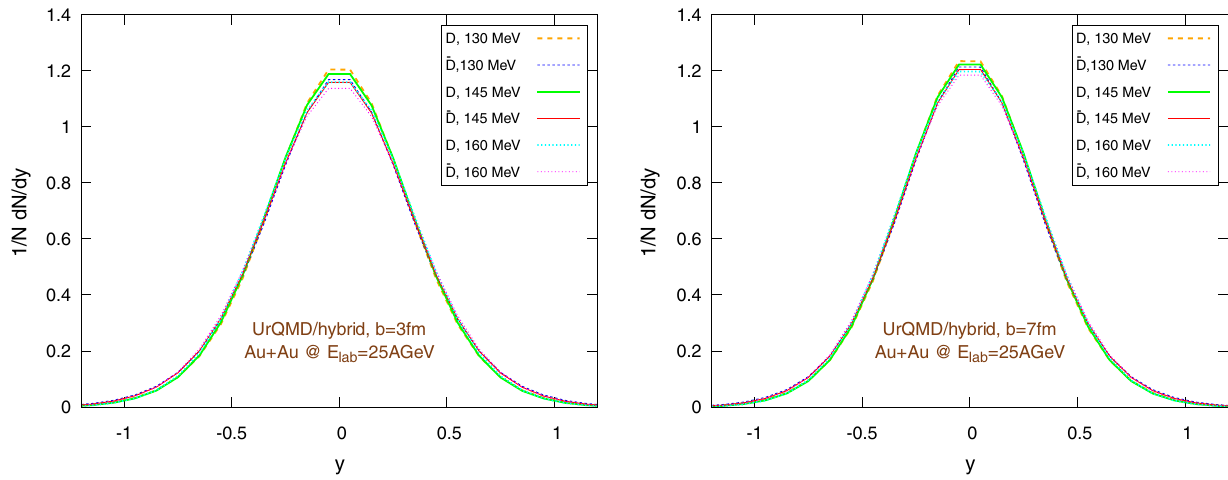
Fig. 12 Final 1 / N d N / d y distribution using the UrQMD/hybrid model for Au+Au collisions at 25 GeV per nucleon in the lab frame, assuming different hadronization temperatures, with fixed parameters: (cid:23) p = 0 . 05 and